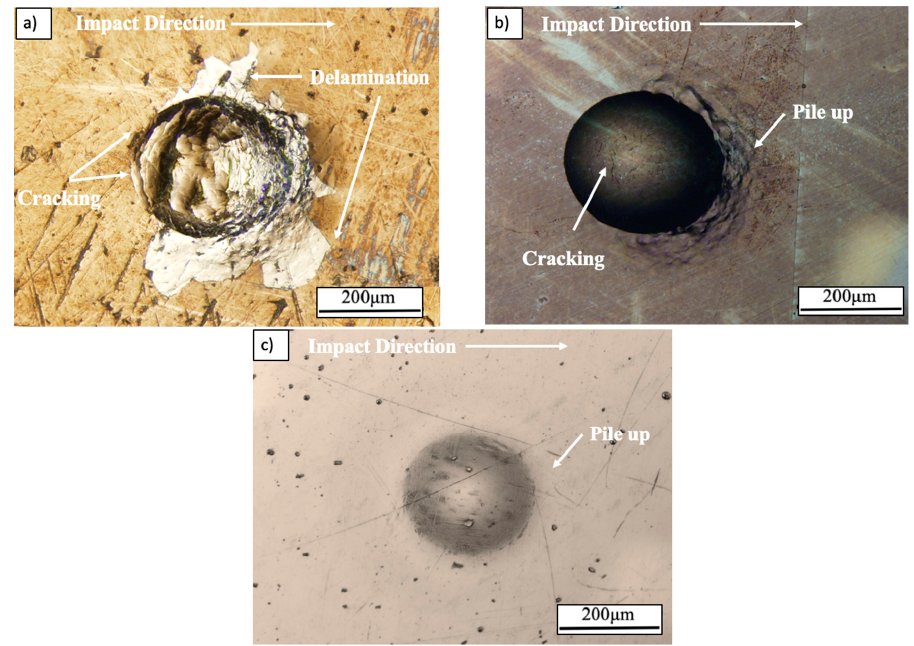
Figure 8. Single particle 30-degree impact ( a ) as-sputtered ( b ) 650 ◦ C nanolaminate ( c ) superelastic NiTi